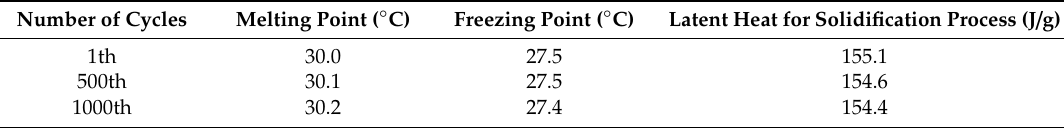
Table 4. Phase change parameters of 4.87% CA-95.13% DE in the multiple cycle test.